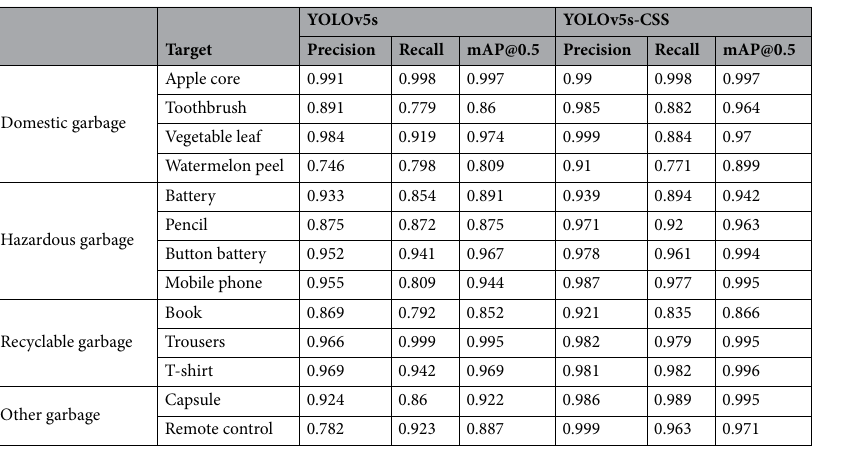
Table 10. Classification accuracy of the proposed YOLOv5s-CSS model and YOLOv5s model training garbage dataset.